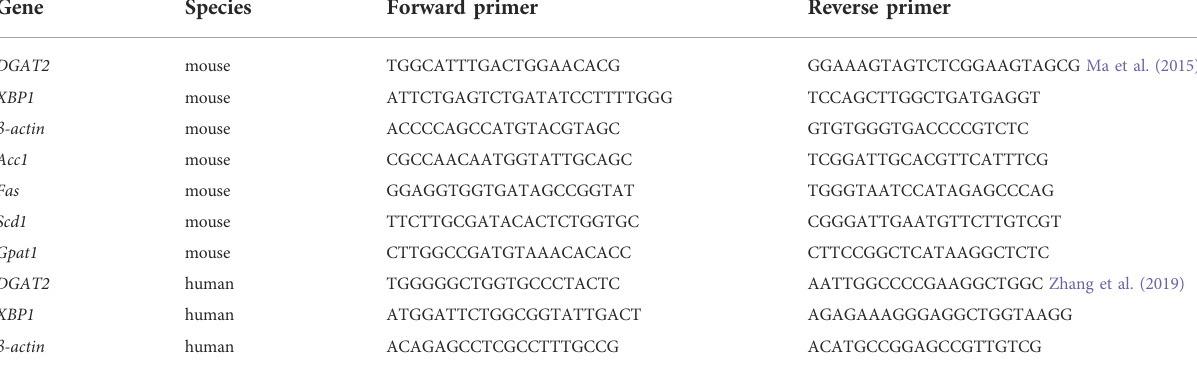
TABLE 1 Quantitative RT-PCR